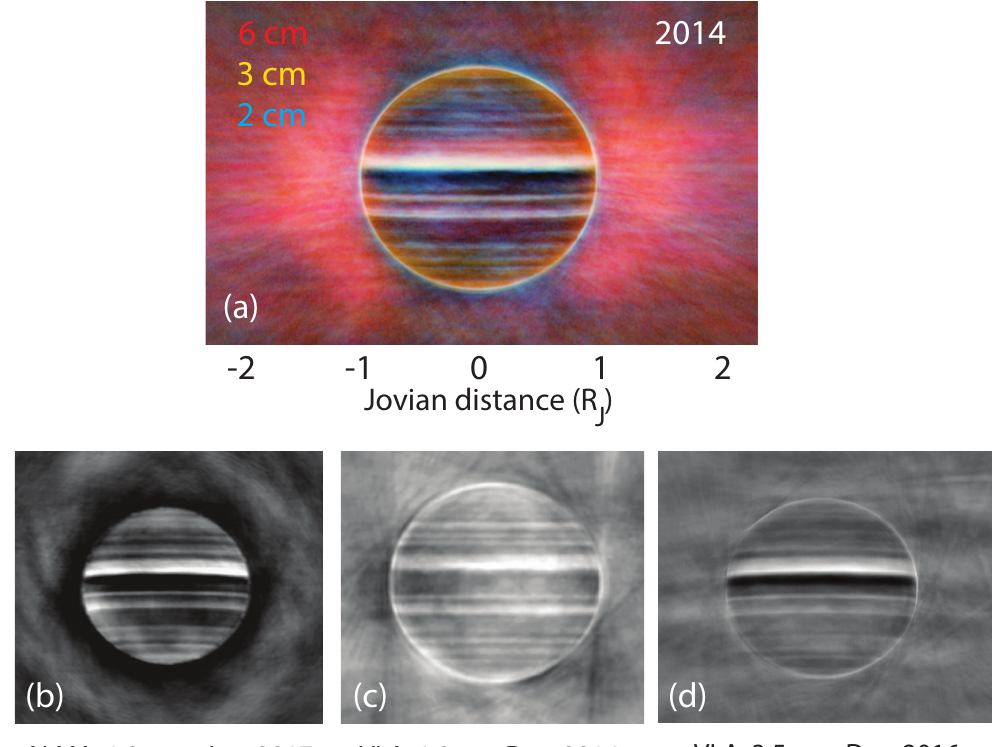
Figure 6. ( a ) Composite radio map obtained with the upgraded VLA in 2014 [97]: 2 cm in blue, 3 cm in gold, and 6 cm in red. A uniform disk has been subtracted from each individual map to better show the fine banded structure on the planet. The pink glow surrounding the planet is the planet’s synchrotron radiation, which is most pronounced at a wavelength of 6 cm. Each map is averaged over 10 h, meaning that these are longitude-smeared maps, and Jupiter’s rotational axis is aligned north-south on the sky. The synchrotron radiation is therefore also smeared latitudinally, because Jupiter’s magnetic axis is inclined 10 ◦ with respect to its rotational axis [97]. ( b – d ) Maps of Jupiter’s thermal radiation obtained with the upgraded VLA and ALMA at different wavelengths and at different times, as indicated. Adapted from Refs.